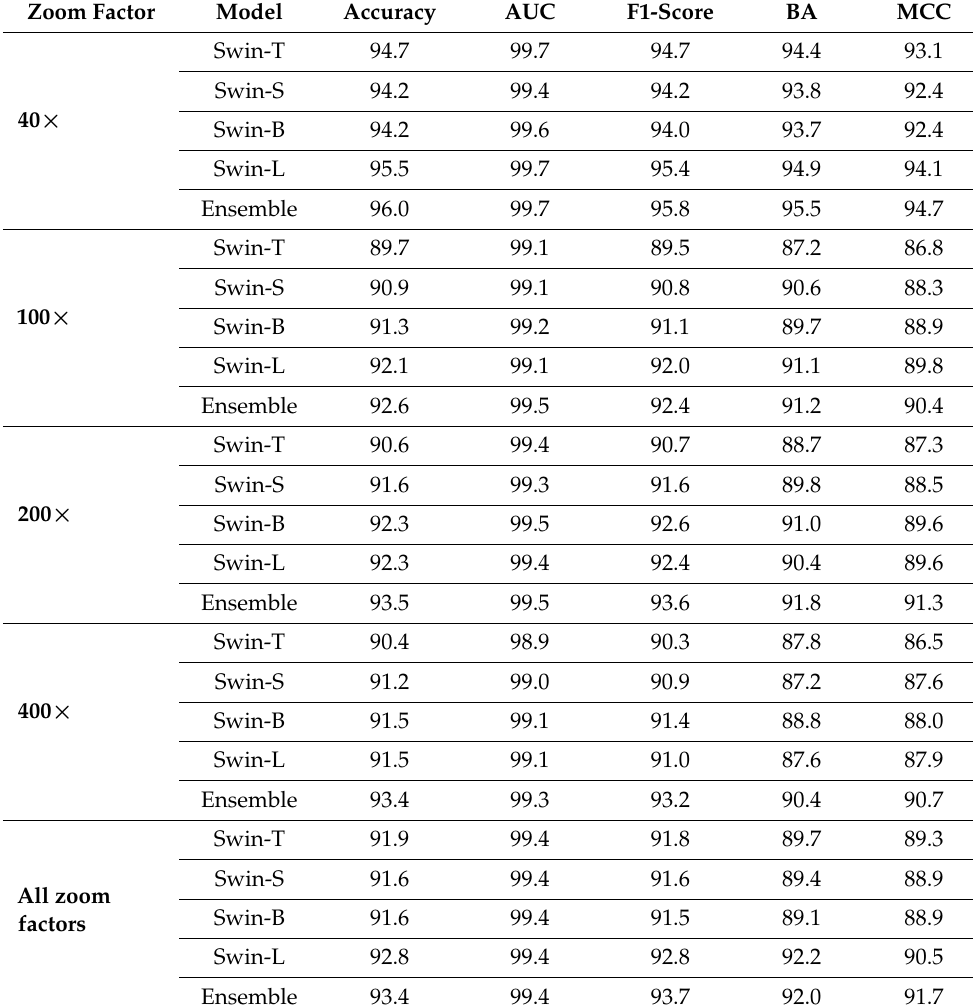
Table 3. Performance metric values on the test set for the eight-class classification (subtypes as listed in Table 1) of BC stratified with respect to images acquired at different zoom factors. AUC : area under the receiver operating characteristic curve, BA : balanced accuracy, MCC : Matthew’s correlation coefficient, T: tiny, S: small, B: base, L: